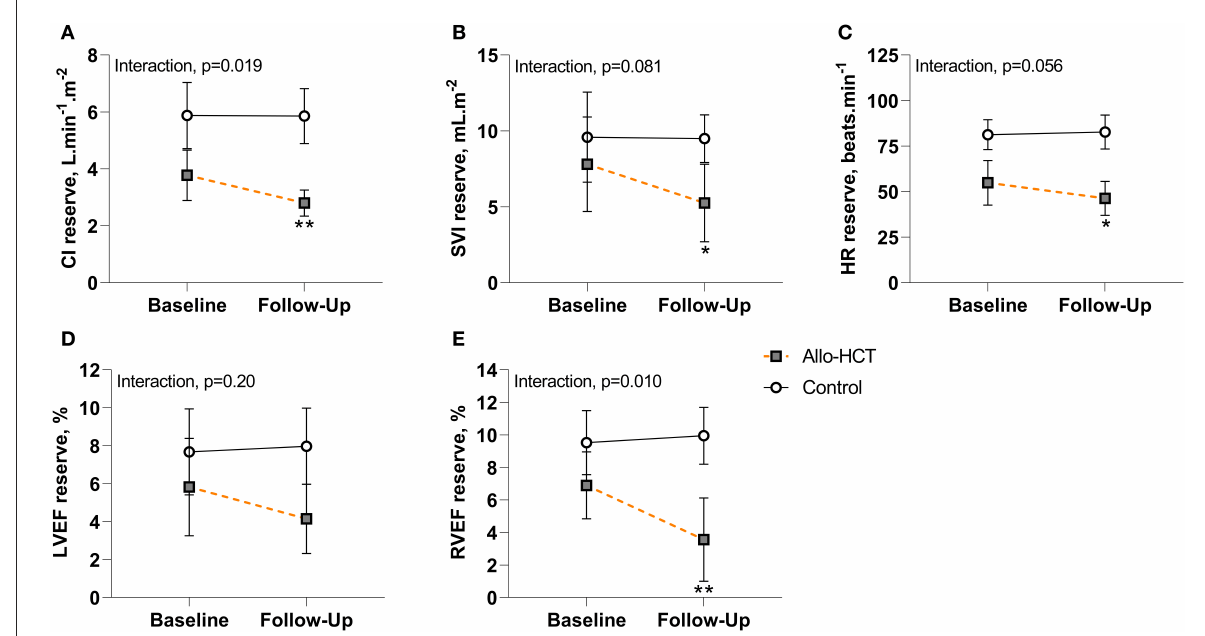
FIGURE2 (A–E) Cardiac and contractile reserve at baseline and 3-month follow-up for Allo-HCT ( n = 12) and Control ( n = 11). After 3-months, cardiac and contractile reserve were maintained in controls, but allo-HCT experienced a blunted CI, SVI, HR, and RVEF reserve, resulting in a significant between-group difference for the net change from baseline for CI reserve and RVEF reserve and a trend toward a significant between-group difference for the net change from baseline for SVI reserve and HR reserve. * p < 0.05 and ** p < 0.01 for within-group change in reserve. Data are unadjusted mean (95% CI). CI, cardiac index; HR, heart rate; LVEF, left-ventricular ejection fraction; RVEF, right-ventricular ejection fraction; SVI, stroke volume